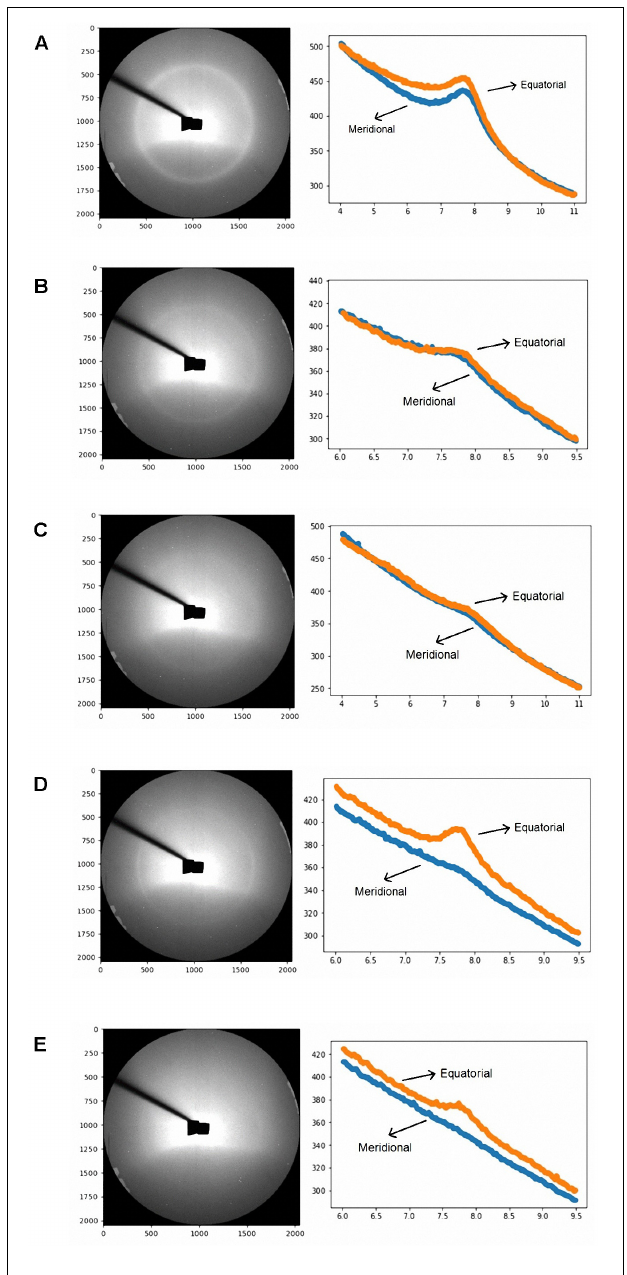
FIGURE 7 | Synchrotron radiation 2D X-ray diffraction patterns of PAN/CNT fibers at different stretching conditions and their 1D equatorial and meridional cross section profiles. (A) PC, (B) PC-S2, (C) PC-S2.5, (D) PC-D5, (E)